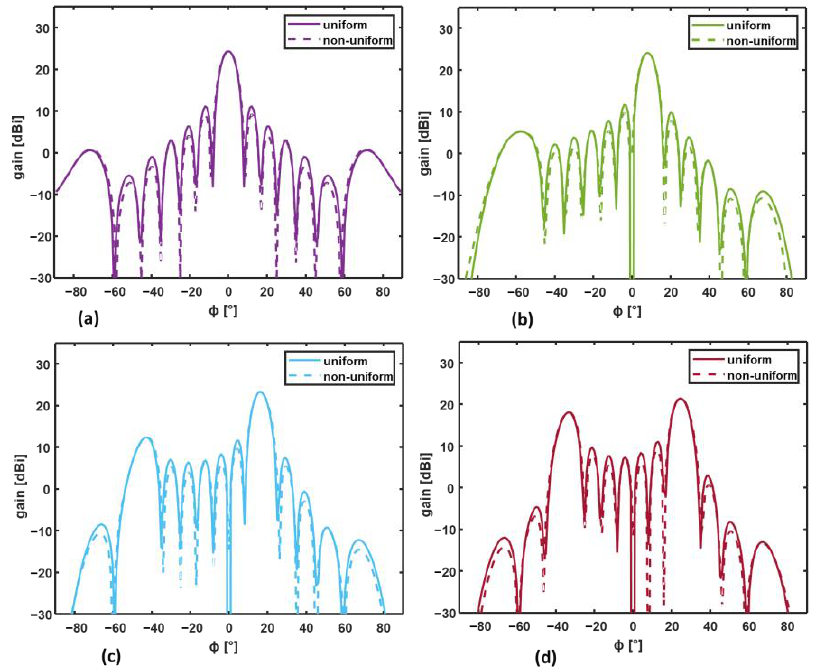
Figure 9. Gain as a function of the angle φ for an array of N a = seven taper antennas calculated for uniform (solid curve) and non-uniform (dashed curves) input power distributions. Different values of the phase shift α are considered: ( a ) α = 0°, ( b ) α = 51.4°, ( c ) α = 102.8°, and ( d ) α = 154.2°. The distance between two adjacent antennas in the OPA is equal to d = λ m , whereas the taper length is L T = 2 μm.